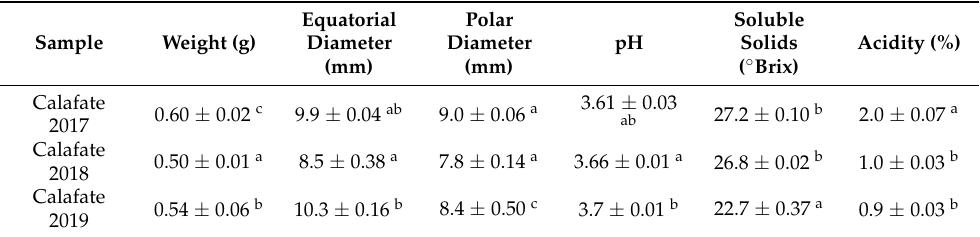
Table 1. Physicochemical parameters of Calafate berries of three consecutive years (2017, 2018 and 2019).